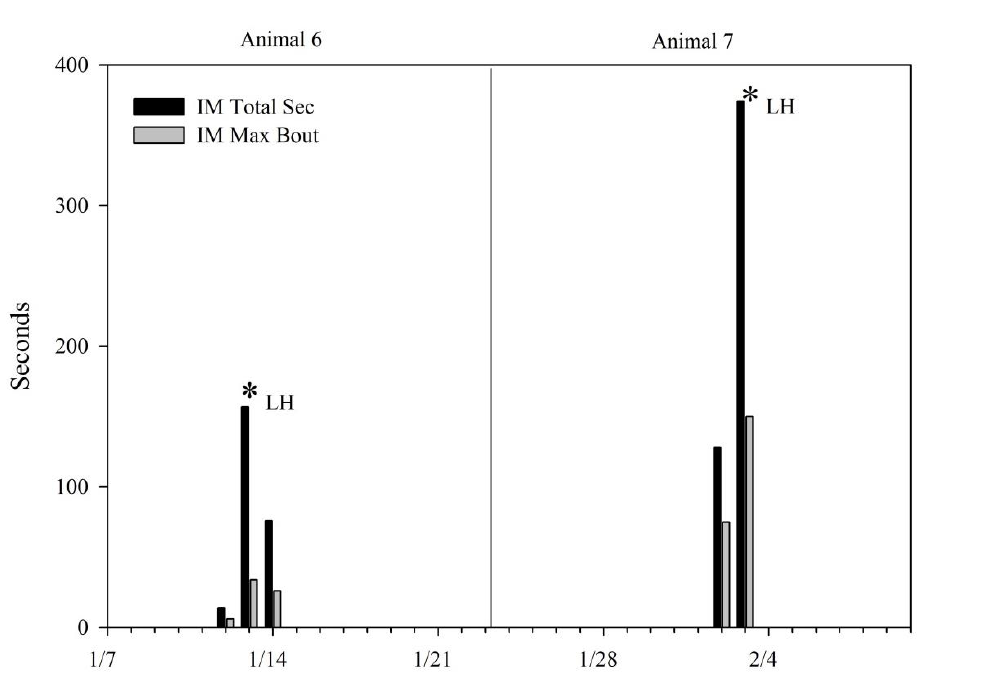
Figure 9. Animals 6 and 7 immobility duration and uLH